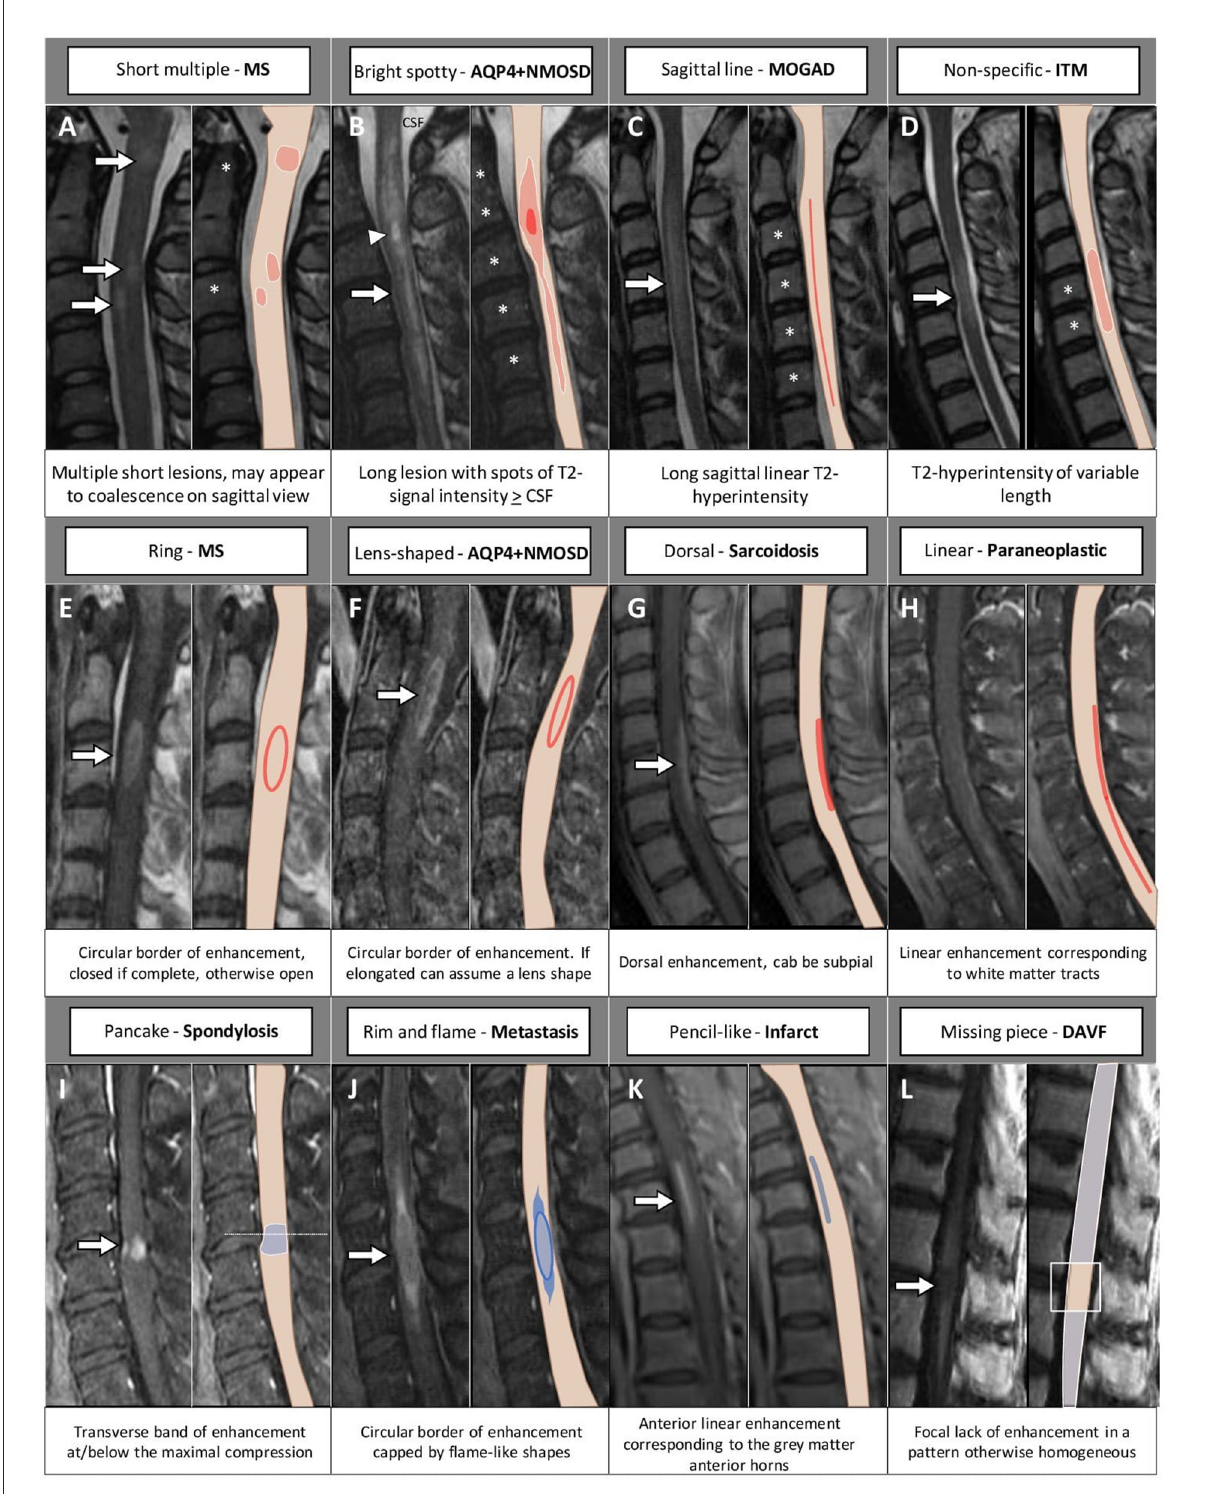
FIGURE3 MRI and corresponding schematic representation of key findings on sagittal view of inflammatory myelopathies and their mimics. Each finding, labeled by a letter (A–L) , is shown on the most appropriate magnetic resonance imaging sequence (e.g., T2-weighted image in the top row; post-contrast T1-weighted image in the bottom rows), a brief description is provided. The extension of the T2-hyperintensities along consecutive vertebral segments is highlighted by asterisks; red color indicates inflammatory myelopathies, while blue color indicates their mimics. The arrowhead in (B) indicates a bright spotty lesion within a longitudinally extensive T2-hyperintensity. AQP4 + NMOSD, aquaporin-4-IgG-positive neuromyelitis optica spectrum disorders; CSF, cerebrospinal fluid; DAVF, dural arteriovenous fistula; ITM, idiopathic transverse myelitis; MOGAD, myelin oligodendrocyte glycoprotein antibody-associated disease; MS, multiple